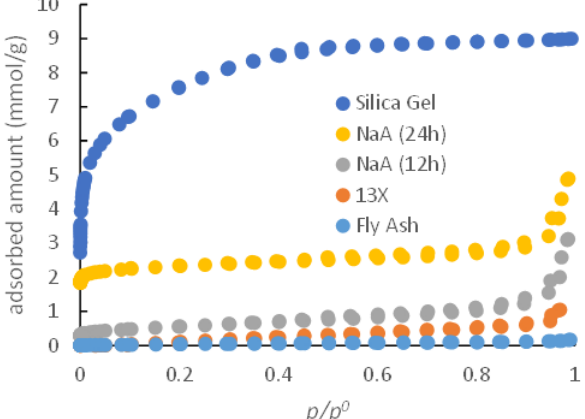
Figure 2. Adsorption Isotherm for Different Samples (at − 196 °C) .